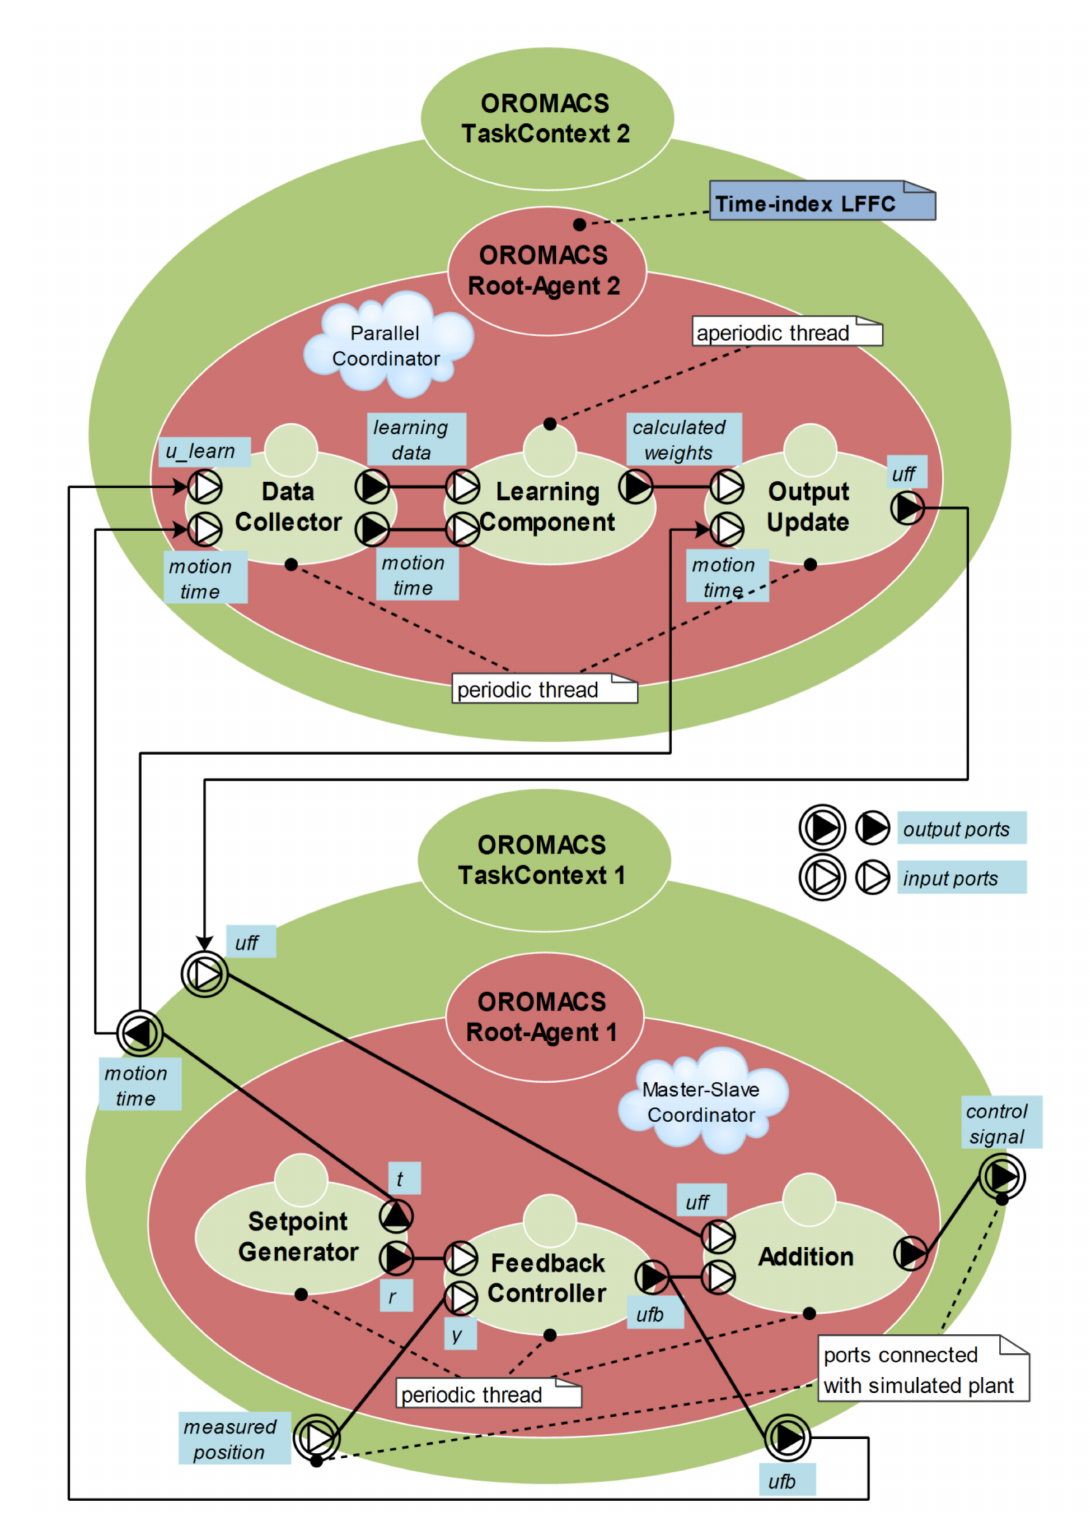
Figure 7. Inside structure of the designed MACS-based time-index LFFC system. OROMACS TC 2 contains a composite OROMACS Root-Agent, as shown in Figure 6, which consists of three components: (1) a data collector, (2) a learning component, and (3) an output update. These components are coordinated by a parallel coordinator.